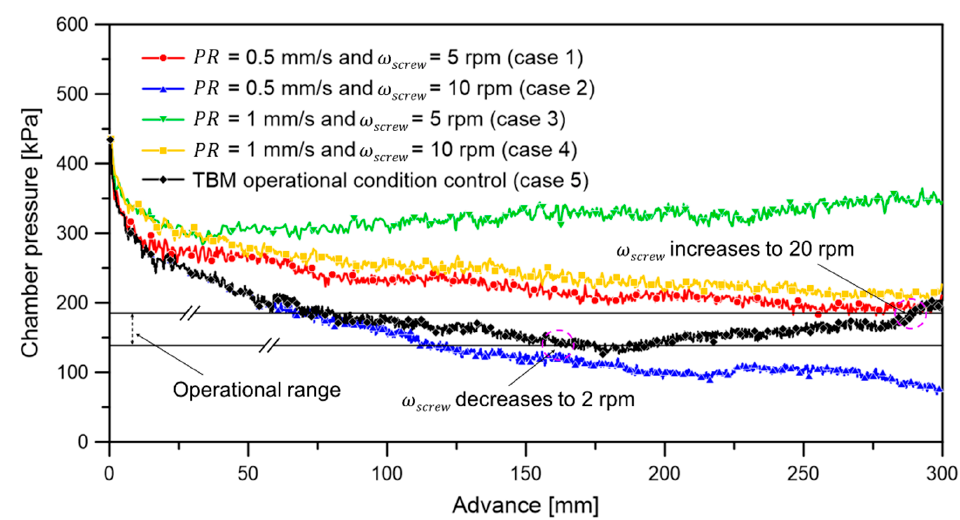
Figure 12. Measured chamber pressure during EPB shield tunnelling simulation.